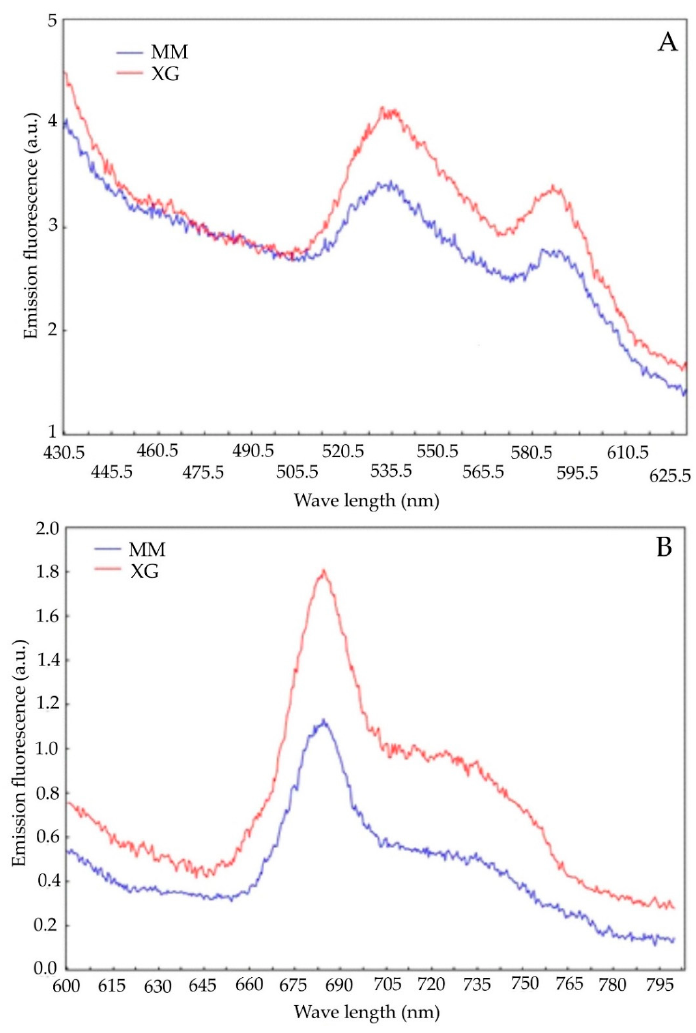
Figure 4. The emission spectra of blue–green ( A ) and red ( B ) fluorescence of Filipendula vulgaris Moench leaves collected from the areas of the Molinia meadows (MM) and xerothermic grasslands (XG).